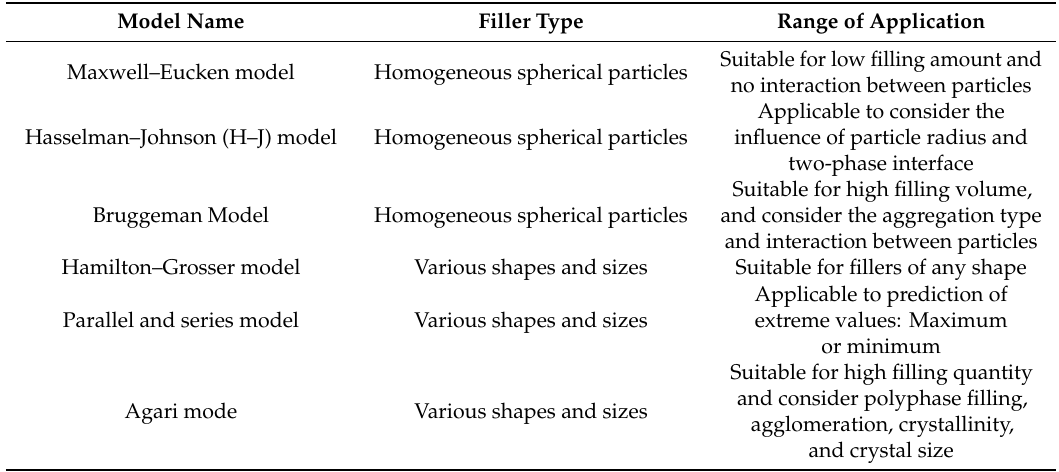
Table 8. Characteristics of thermal conductivity